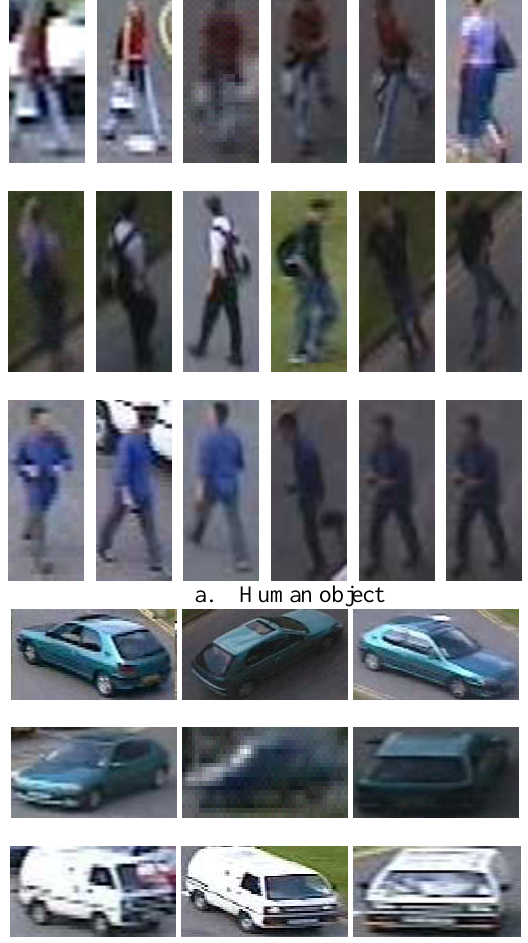
Figure 8: The result of human object classification